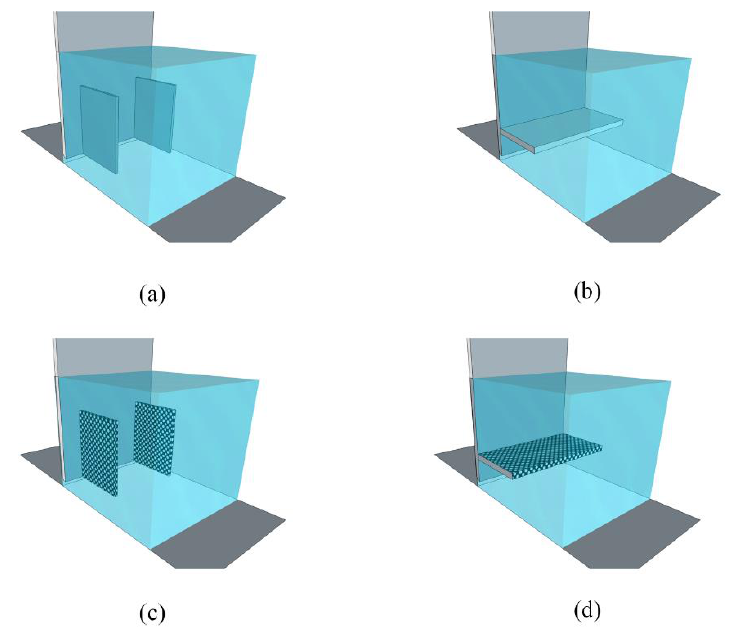
Figure 9. Vortex breakers mounted on the downstream face of the gate: ( a ) vertical solid ba ffl e; ( b ) horizontal solid ba ffl e; ( c ) vertical porous ba ffl e; ( d ) horizontal porous ba ffl e. The control volume is depicted as transparent volume.